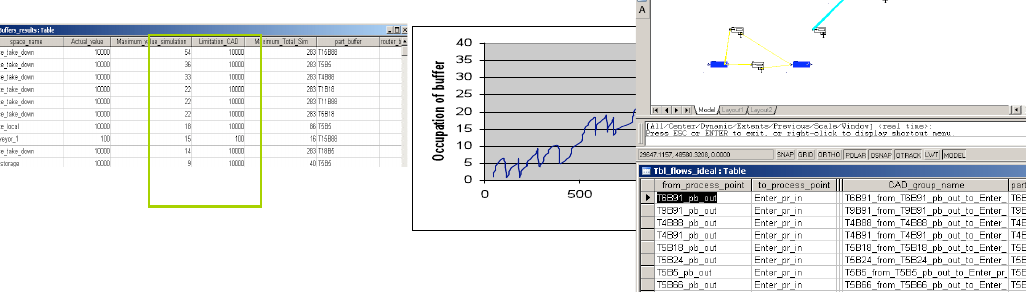
Fig. 9. Maximum occupation for each part and storage occu- pation plot (right side)